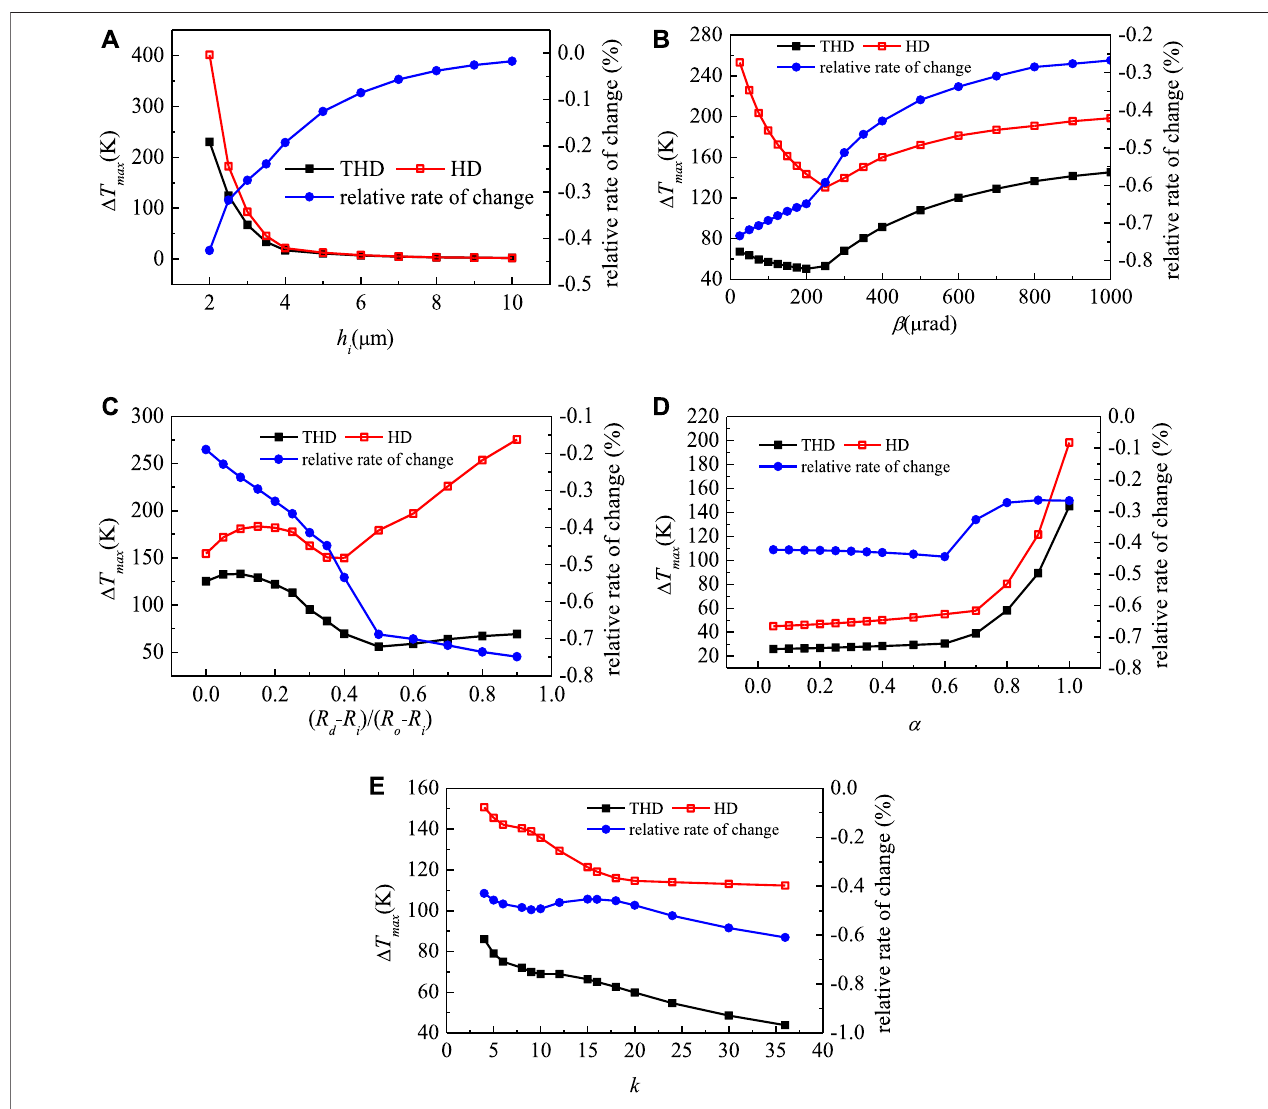
FIGURE 7 | Effect of structural parameters under the viscosity-temperature effect on the maximum temperature difference in the liquid fi lm.